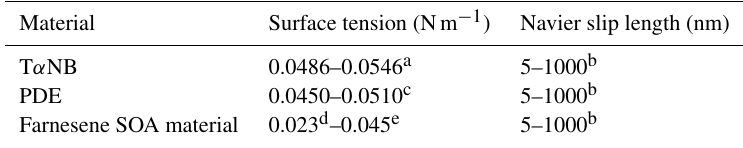
Figure 5. Hot-stage microscopy experiments with PDE. Roundness as a function of time at (a) 46.1 ◦ C and (c) 35.6 ◦ C. The squared difference between observed and simulated roundness as a function of simulated viscosity for the two sample experiments, where panel (b) corresponds to panel (a) and panel (d) to panel (c) . The simulation that best reproduces the observation corresponds to the minimum sum of squared difference. The different colors correspond to different input combinations of surface tension and slip length used in the simulations, where U ST , U slip , L ST , and L slip correspond to the upper limit of surface tension, the upper limit of slip length, the lower limit of surface tension, and the lower limit of slip length, respectively. Table 1. Input values of surface tension and slip length used in fluid dynamics